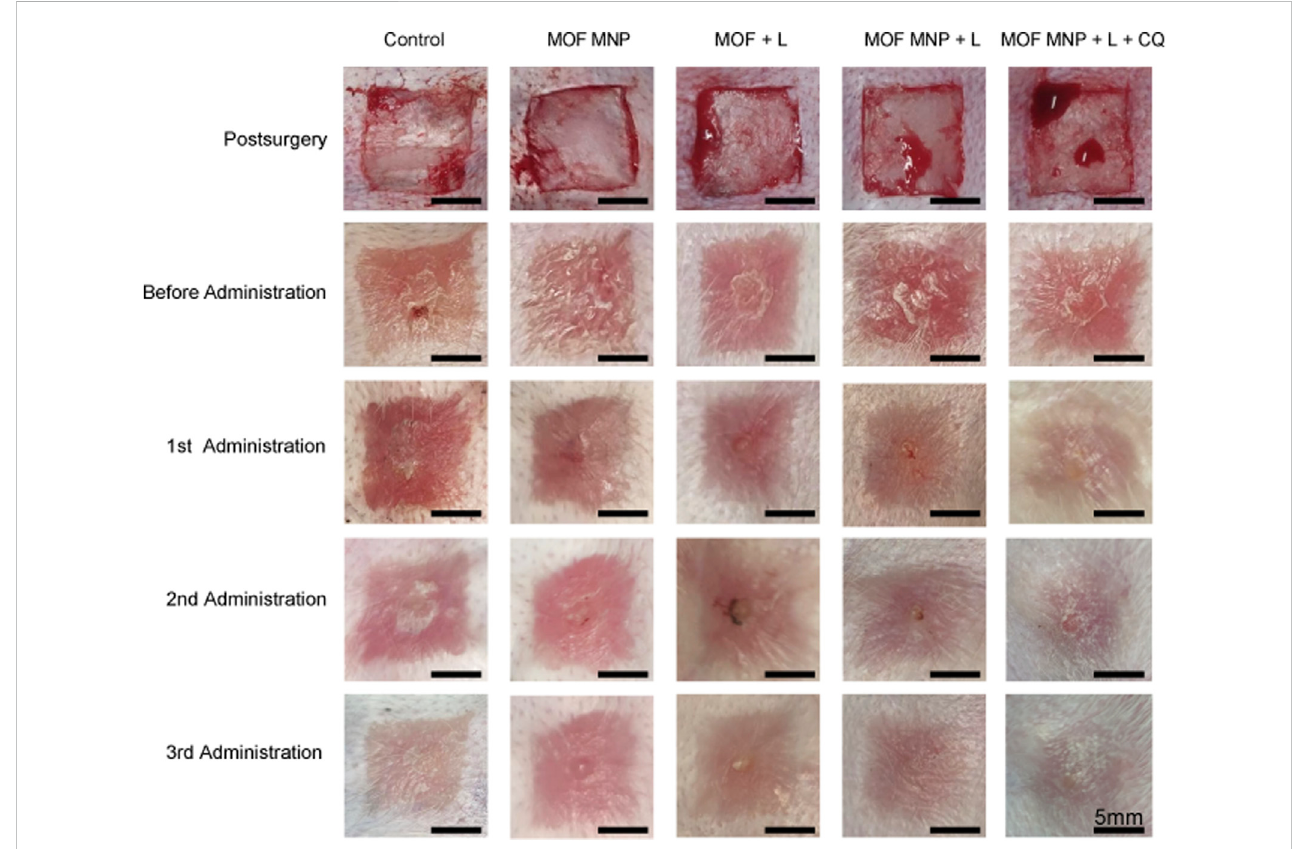
FIGURE 4 Treatment effect of rabbit HSs by different groups. (L: light, n =